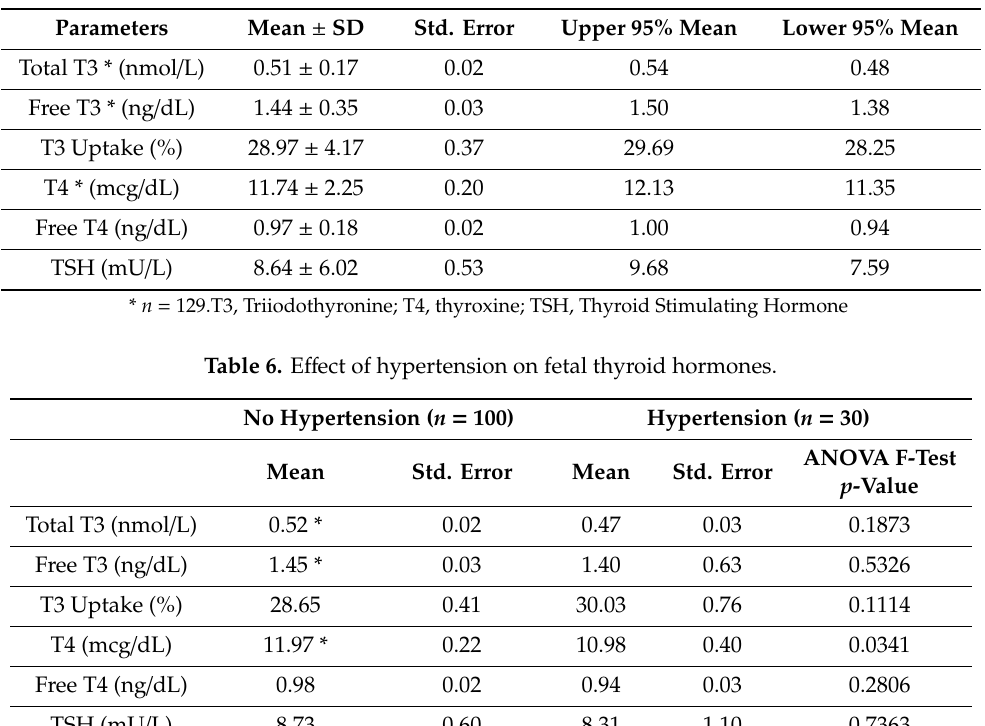
Table 5. Umbilical cord blood thyroid hormone levels. Reported mean ± SD. 95% confidence interval.